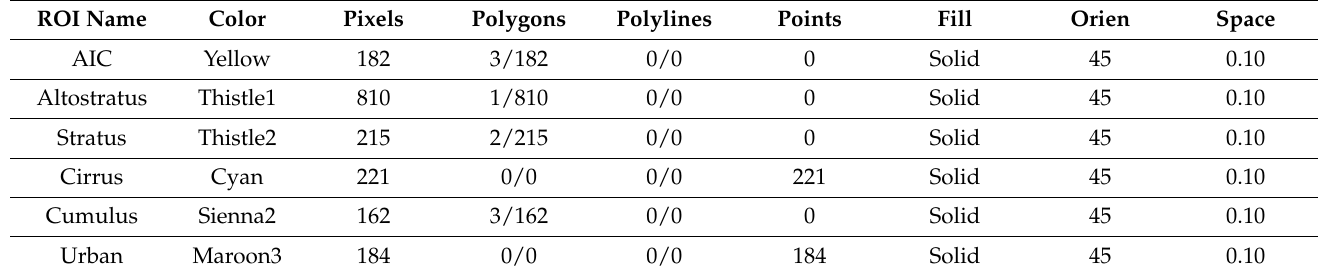
Table 2. Regions of interest.